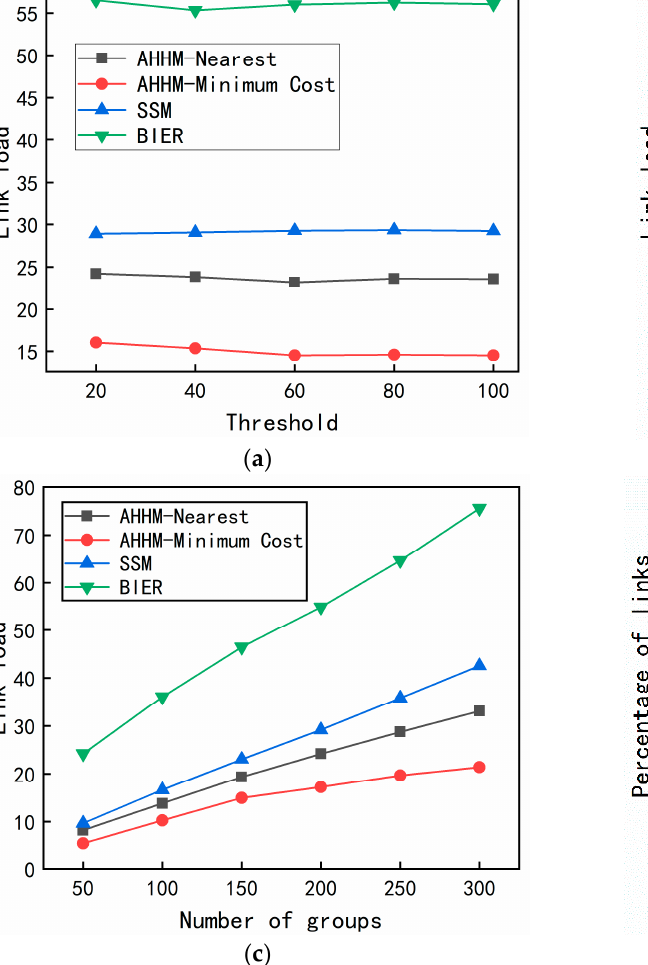
Figure 10. The comparison of link load. ( a ) The comparison of the link load with different thresholds; ( b ) The comparison of the link load with different numbers of receivers; ( c ) The comparison of link load with different numbers of groups; ( d ) The CDF of the link load in each multicast